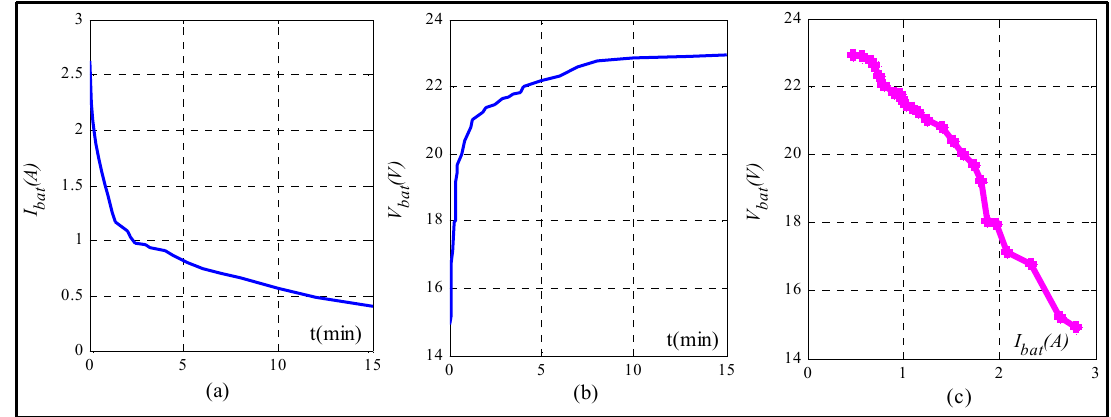
Figure 14. Batteries recharging profiles versus time: ( a ) I bat . ( b ) V bat . ( c ) battery generated voltage.